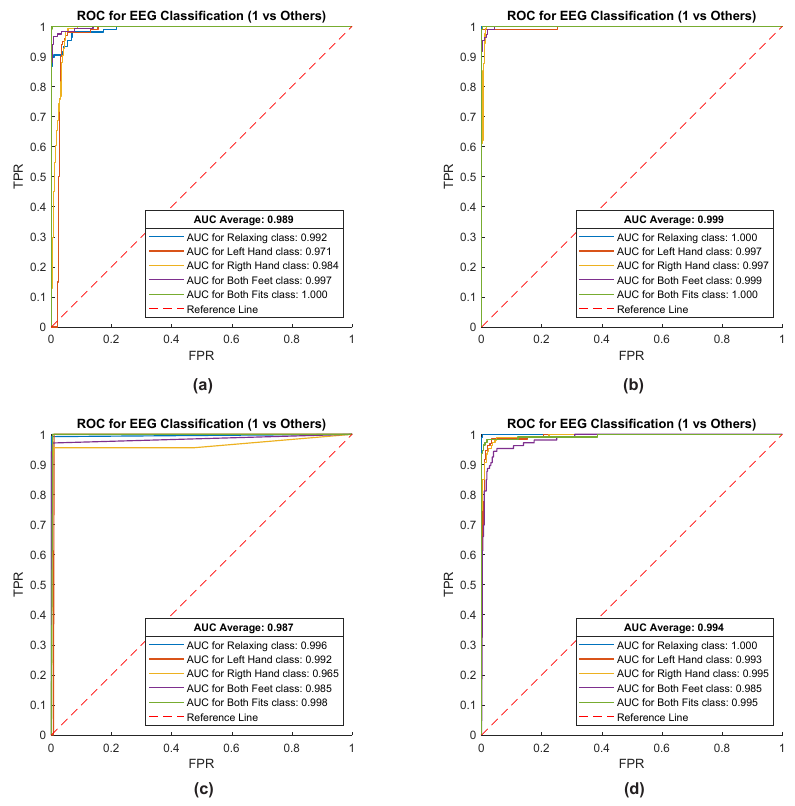
Figure 6. The receiver operating characteristic (ROC) curves of the top four ML algorithms trained for EEG signals classification, related to the movements of hands and feet: ( a ) ROC curves of the LDA algorithm, ( b ) ROC curves of the SVM algorithm, ( c ) ROC curves of the D.T. algorithm, and ( d ) ROC curves of the N.B.